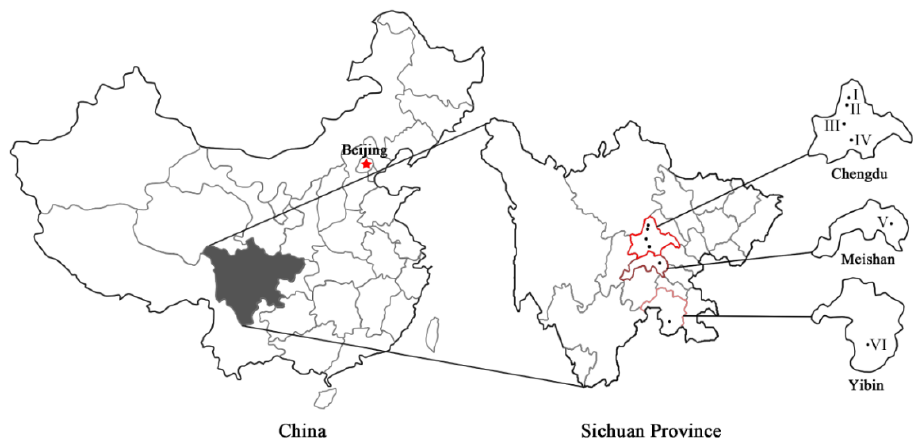
Figure 1. Maps of the six bamboo forest sites in this study. I— Phyllostachys praecox f. prevernalis in Zhuhaidongtian in Chengdu; II— Phyllostachys praecox f. prevernalis in Tongmagou in Chengdu; III— Neosinocalamus affinis in Chongzhou in Chengdu; IV— Neosinocalamus affinis in Xinjin in Chengdu; V— Phyllostachys heterocycle var. pubescens in Renshou in Meishan; VI— Dendrocalamus latiflorus in Changning in Yibin.